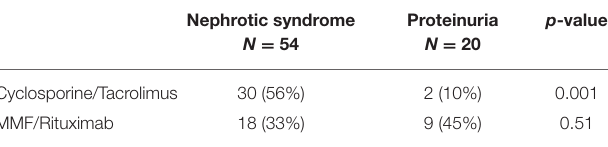
TABLE 5 | Nephrotic patients and non-nephrotic proteinuria in relation to the treatment